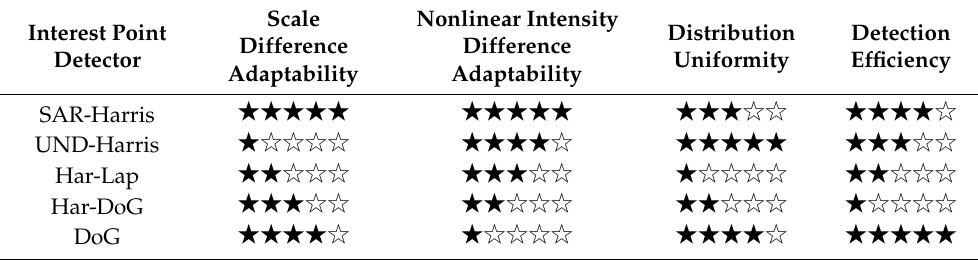
Table 4. Comprehensive performance evaluation of five